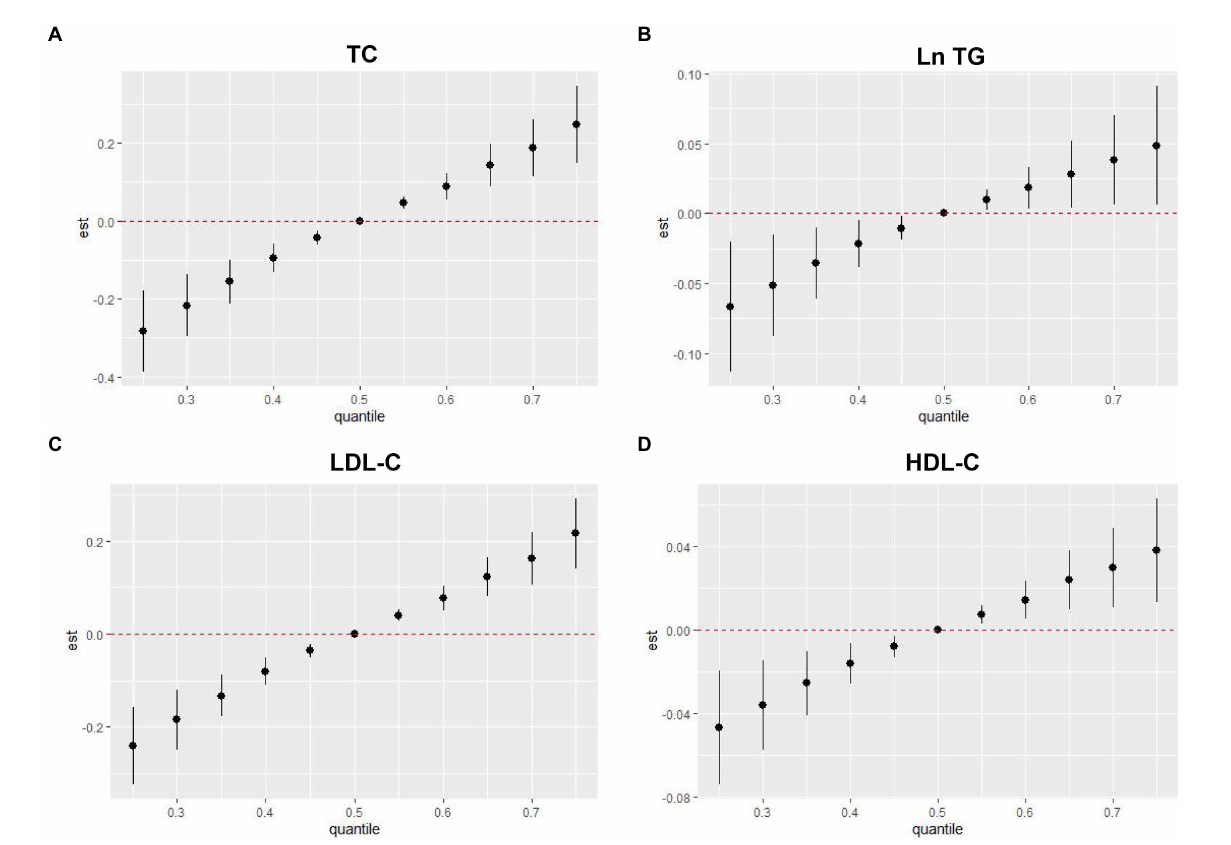
FIGURE 3 Overall associations of metal mixture including blood Pb and essential metals with serum lipid profiles in the BKMR model. (A) Metal mixture and TC, (B) metal mixture and Ln TG, (C) metal mixture and LDL-C, and (D) metal mixture and HDL-C. TG, blood Pb and essential metal concentrations were transformed to natural logarithm for further analysis. The model was adjusted for age, sex, educational, smoking status, abuse drinking, BMI categories, diabetes, and hypertension. Compared with the 50th percentile, the estimate at any percentile where the 95% confidence interval does not include 0 is considered statistically significant. TC, total cholesterol; TG, triglyceride; LDL-C, low-density lipoproteins cholesterol; HDL-C, high-density lipoproteins cholesterol; BMI, body mass index; Mg, magnesium; Mn, manganese; Ca, calcium; Fe, iron; Cu, copper; Zn, zinc; Pb,